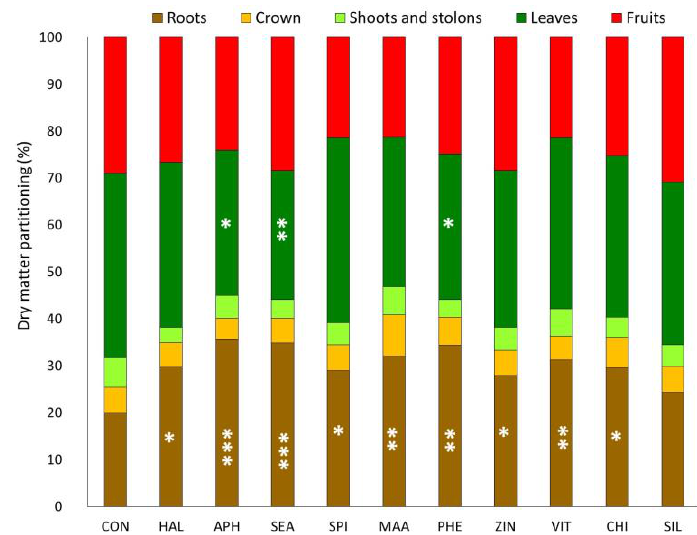
Figure 2. Dry matter distribution in strawberry plant organs treated with di ff erent biostimulant products and water (control). n = 4. The asterisk indicates significant di ff erences between a single treatment group and control group within each plant organ, according to Dunnett’s test. *** p < 0.001; ** p < 0.01; * p < 0.05; no asterisk indicates absence of any significant di ff erences. Treatments legend: CON, control; HAL, humic acids; APH, alfalfa protein hydrolysate; SEA, macroseaweed extract; SPI, microalga hydrolysate; MAA, mix of amino acids; PHE, MAA combined with pure phenylalanine; ZIN, MAA combined with zinc; VIT, B-group vitamins; CHI, chitosan; SIL, Siliforce ® . Relative leaf dry matter allocation was significantly lower in SEA-, APH-, and PHE-treated plants, whereas in fruits, crown, shoots, and stolons, there were no significant di ff erences as compared to the control. At di ff erent phases of the experimental cycle, the leaf area of plants treated with APH, VIT, CHI, and SIL was significantly larger than control ( + 15%–30%), whereas humic acids (HAL) and PHE applications significantly reduced the leaf surface (about 80 cm 2 compared to 100 cm 2 in control plants) at the end of the experiment (Figure